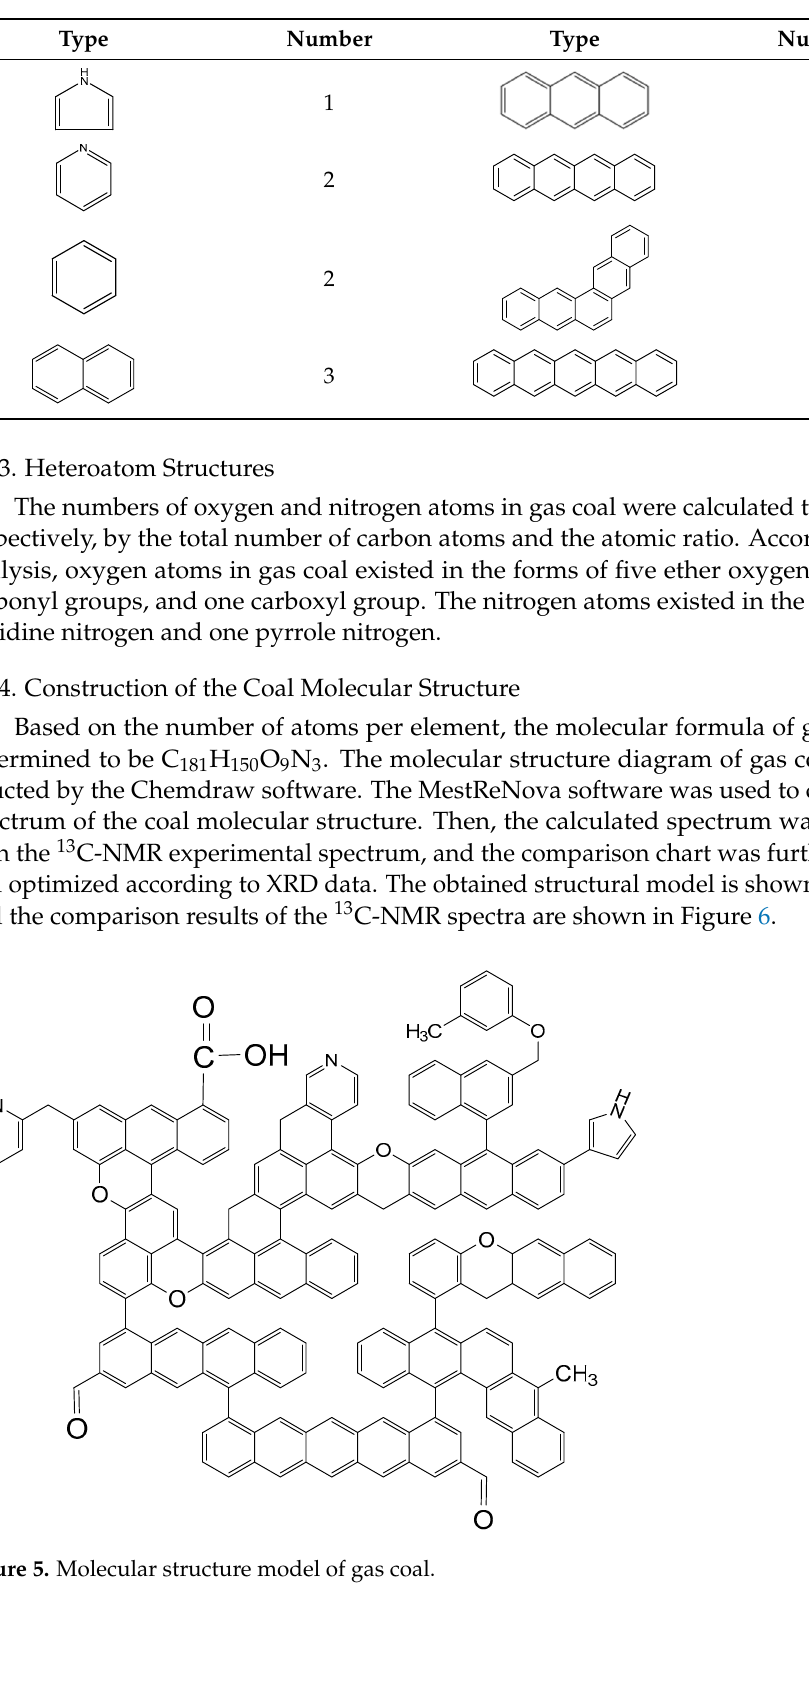
Figure 6. Experimental and calculated 13 C-NMR spectra. -100